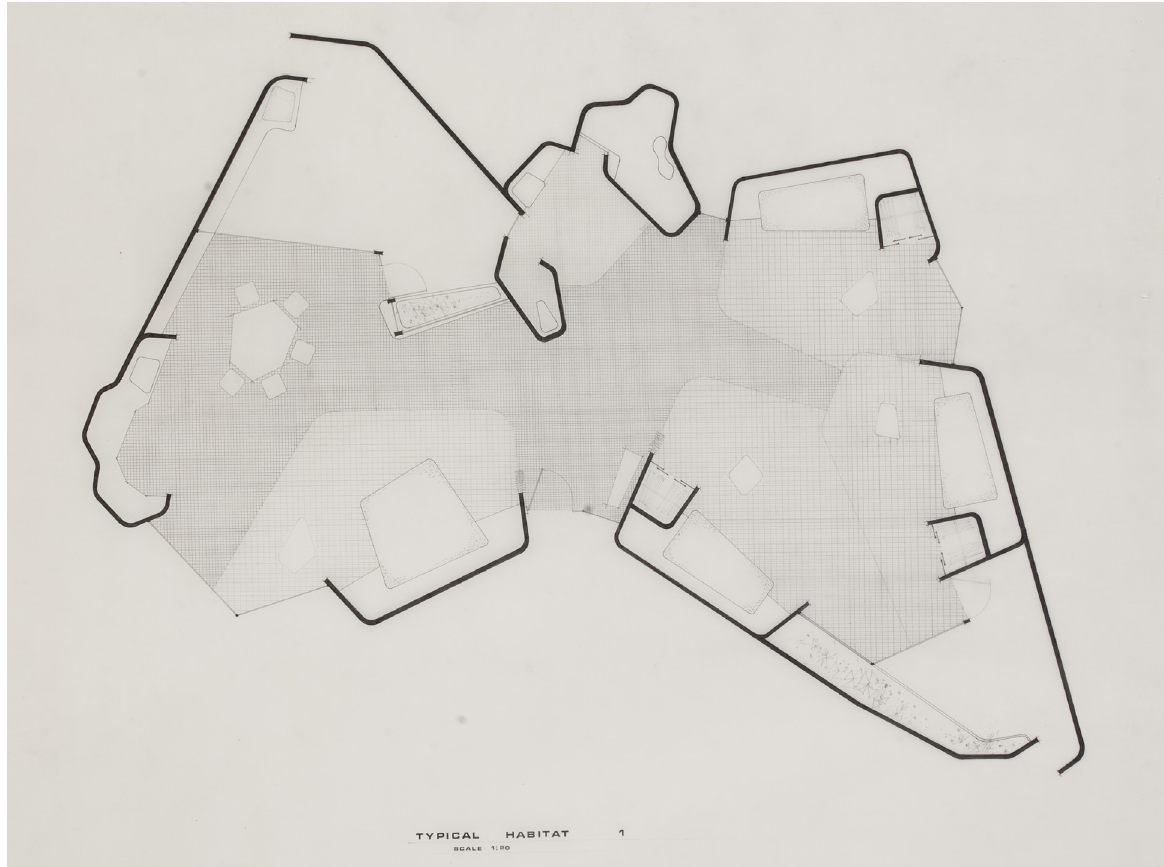
IMG.5: Macrostructure for an